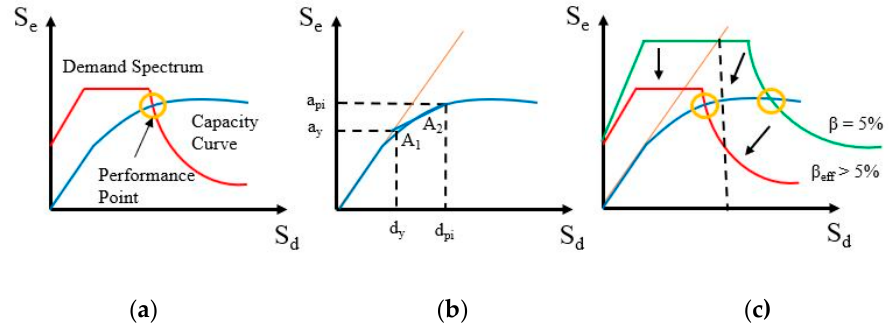
Figure 1. ( a ) Performance point calculation; ( b ) Capacity curve idealization; ( c ) Scaled demand spectrum [9].